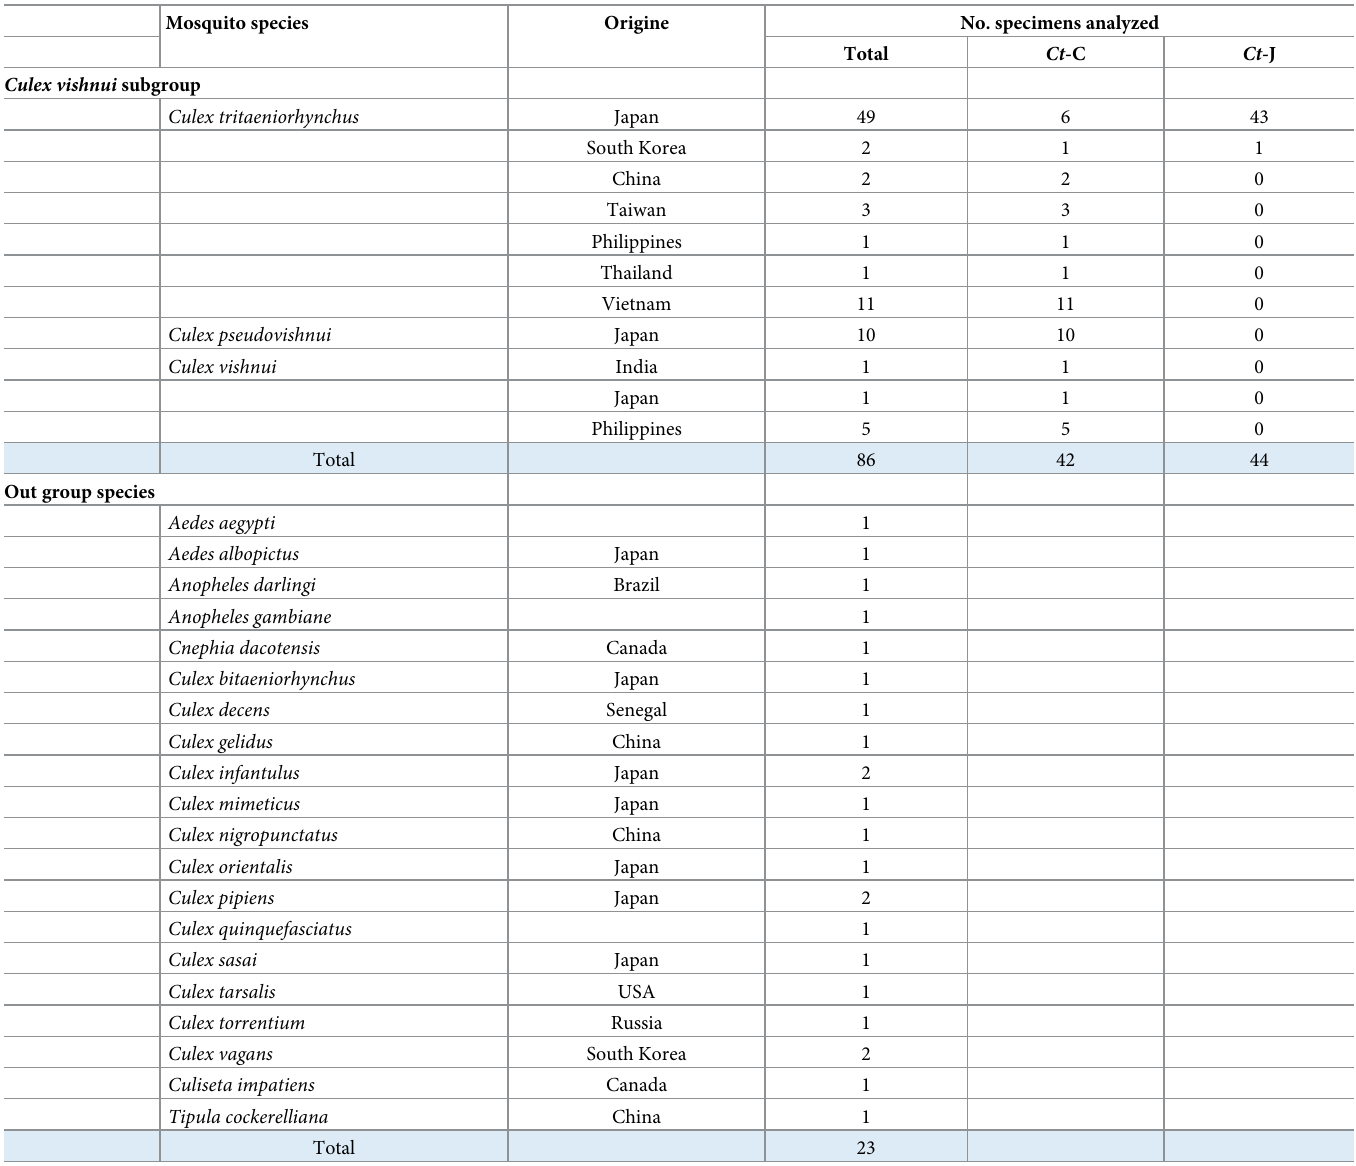
Table 1. Mosquito specimens used in this